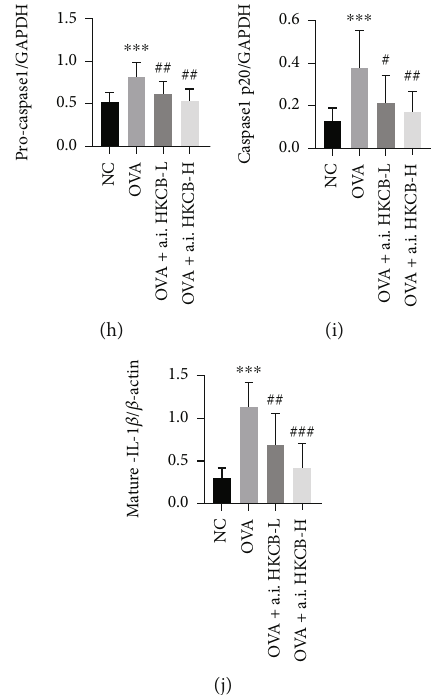
Figure 4: The e ff ect of aerosol inhalation of HKCB on the NF- κ B/NLRP3 in fl ammasome signaling pathway in the lung tissues of allergic mice. (a) Expression levels of NF- κ B p65 and NLRP3 in lung tissues, as examined by immunohistochemistry staining (magni fi cation 200x). (b, c) Expression scores of NF- κ B p65 and NLRP3 in lung tissues. (d) Expression levels of NF- κ B p65, NLRP3, ASC, pro- caspase1, caspase1 p20, and mature-IL-1 β in lung tissues were examined using western blotting. (e – j) Relative expression levels of NF- κ B p65, NLRP3, ASC, pro-caspase1, caspase1 p20, and mature-IL-1 β in lung tissues. ∗∗ P < 0 : 01 and ∗∗∗ P < 0 : 001 versus the NC group; # P < 0 : 05 , ## P < 0 : 01 , and ### P < 0 : 001 versus the OVA group. a.i.: aerosol inhalation; CB: Clostridium butyricum ; HKCB: heat-killed